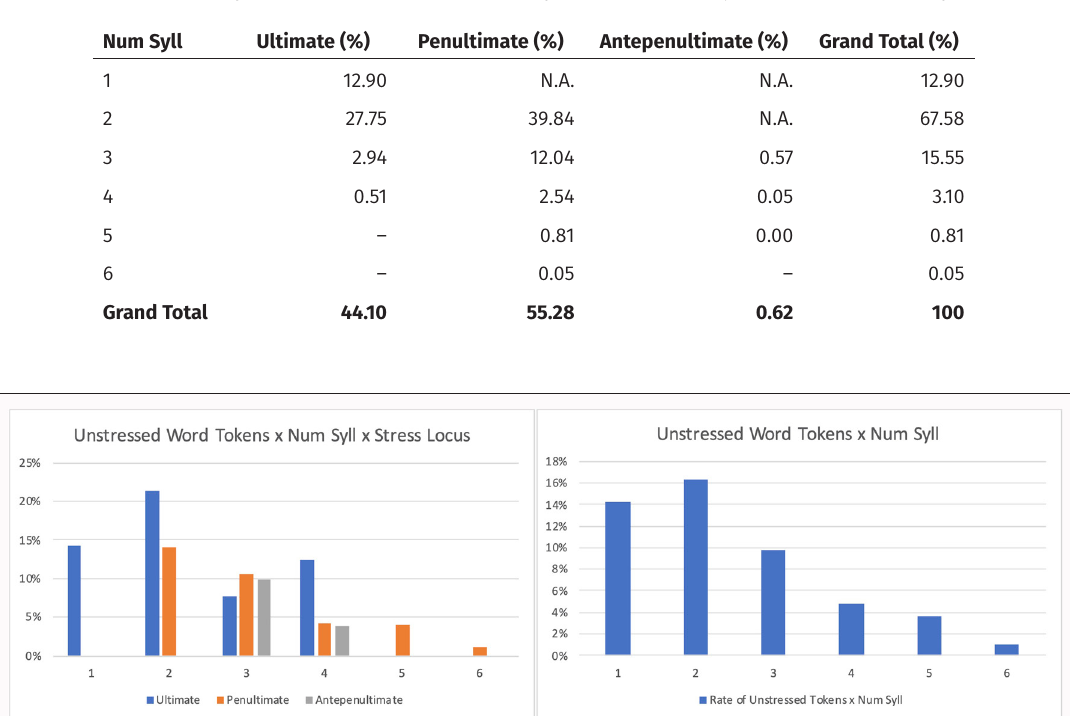
Table 8: Word tokens predicted to be Unstressed per number of syllables and stress position.